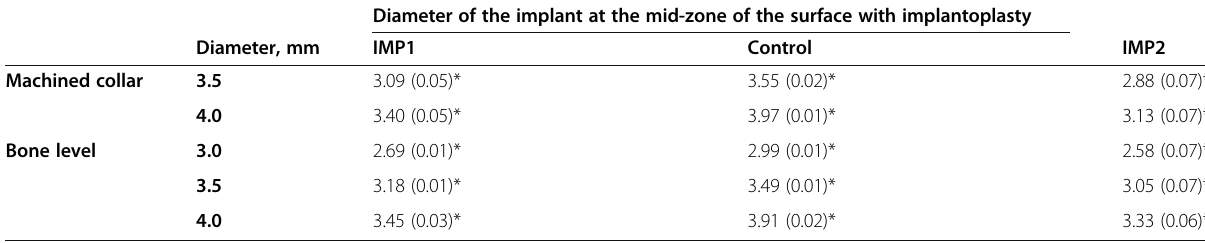
Table 2 Mean diameters for the different types of implant design measured at the center of the surface over which implantoplasty was performed Diameter of the implant at the mid-zone of the surface with implantoplasty